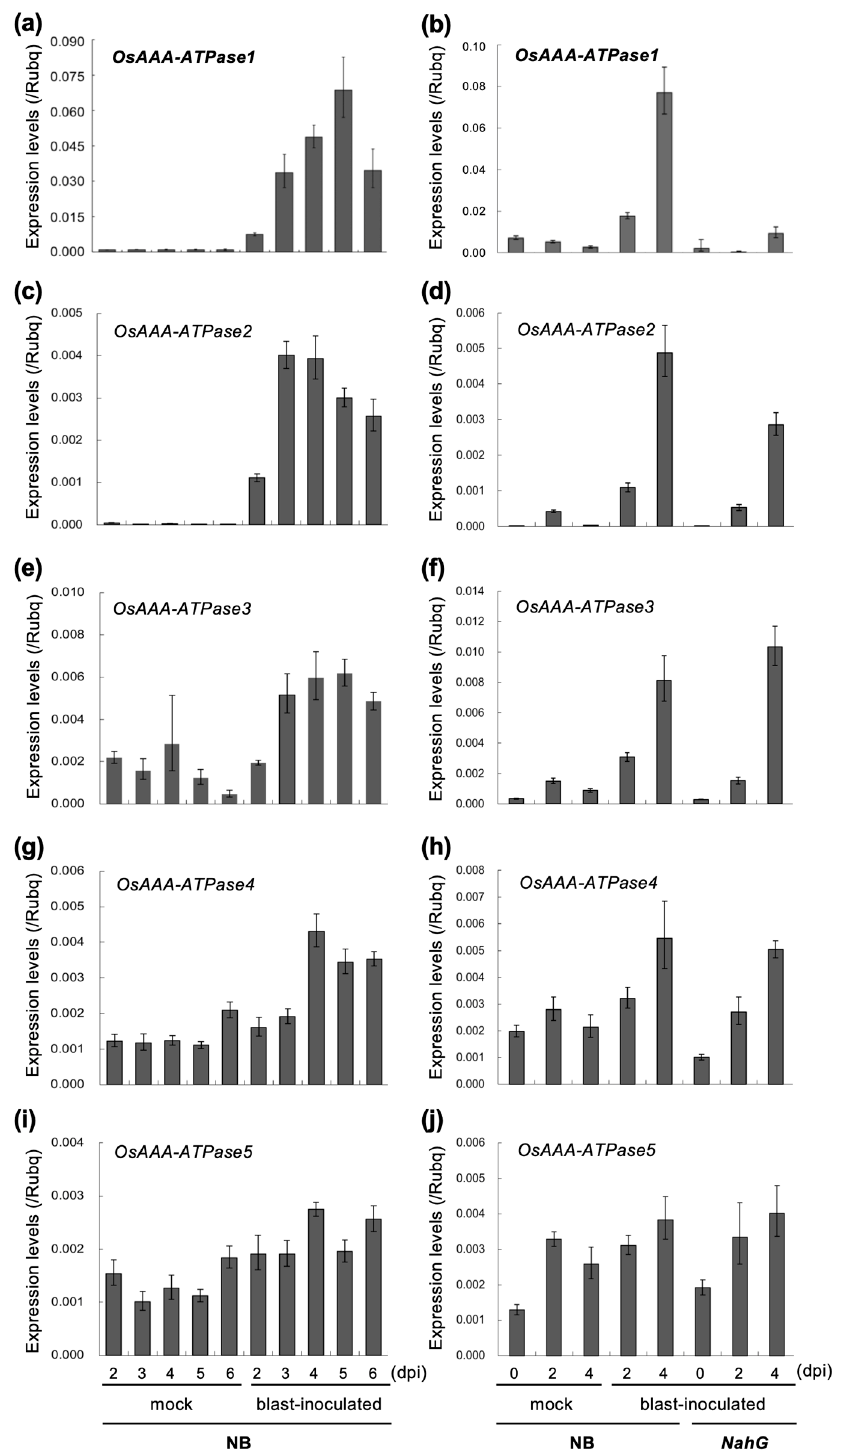
Figure 3. Expression analysis of OsAAA-ATPase1–5 ( a – j ) in response to blast inoculation in Nipponbare (NB) and narG rice seedlings. Rice seedlings at the four-leaf stage (three true leaves) were subjected to mock treatment (mock) or blast inoculation (blast-inoculated), and the fourth leaf blades were sampled at indicated days post inoculation (dpi). Data are represented as means ±